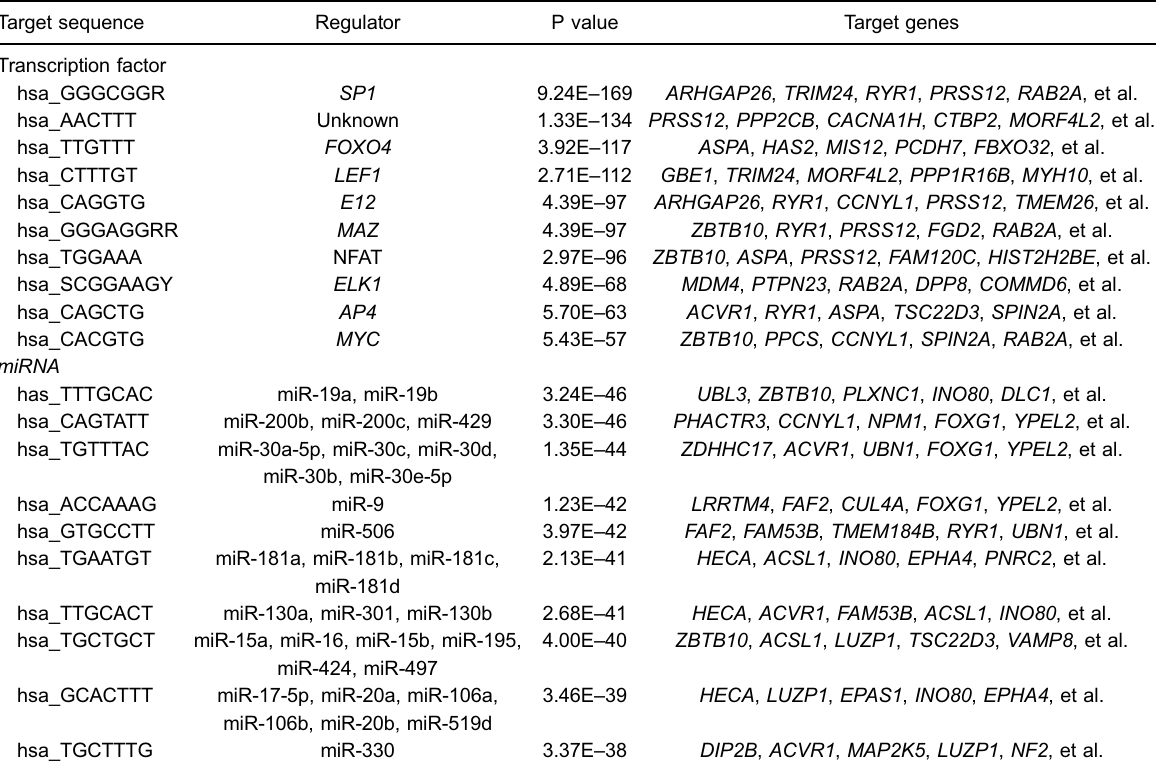
Table 2. Top 10 potential transcription factors and miRNAs of differentially expressed genes (DEGS) in dilated cardiomyopathy. Target